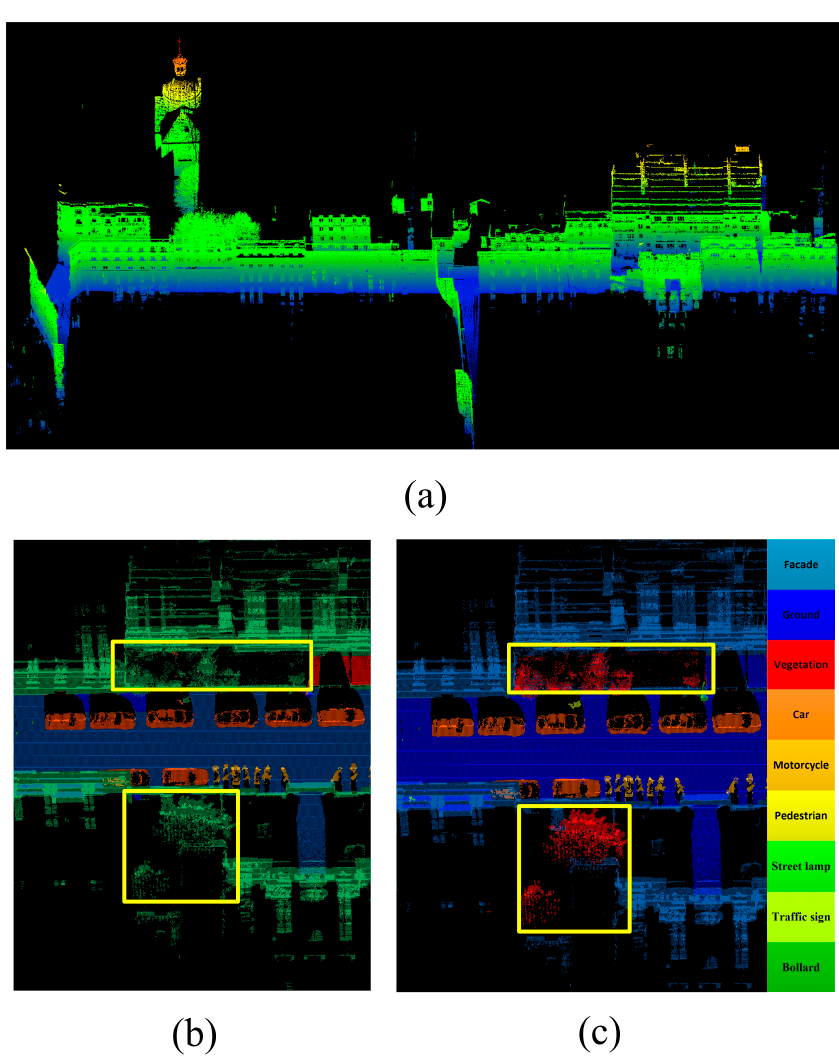
Figure 6. Details of the Paris-rue-Cassette dataset. (a) The original point clouds. (b) The region of mislabeling points of vegetation. (c) Correction for mislabeling points of vegetation.